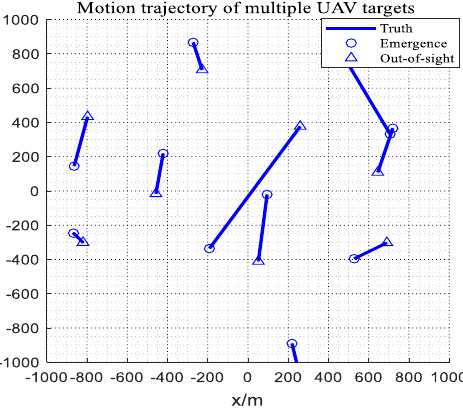
Figure 4. Real motion trajectories of UAV targets.